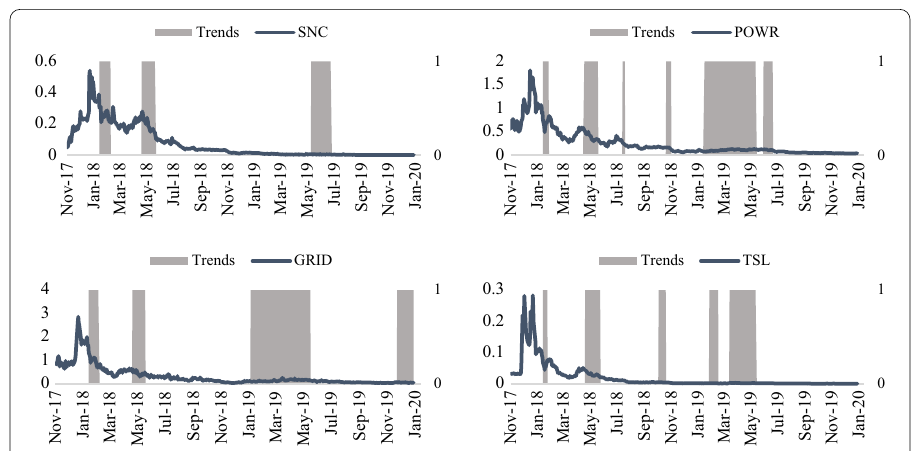
Fig. 6 Energy crypto prices and trends (Nov 2017–Jan 2020). Note : The four energy cryptos are also listed, namely SunContract (SNC), Powerledger (POWR), Grid (GRID) and Energo (TSL). A trend is assumed to + come into existence if the slope of the last 50 days is greater or less than zero. An upward (downtrend) trend is in place when the slope is positive (negative). The grey (white) areas signify periods with uptrends (downtrends). Source : S&P 500 Dow Jones Indices, Coinmarketcap, and